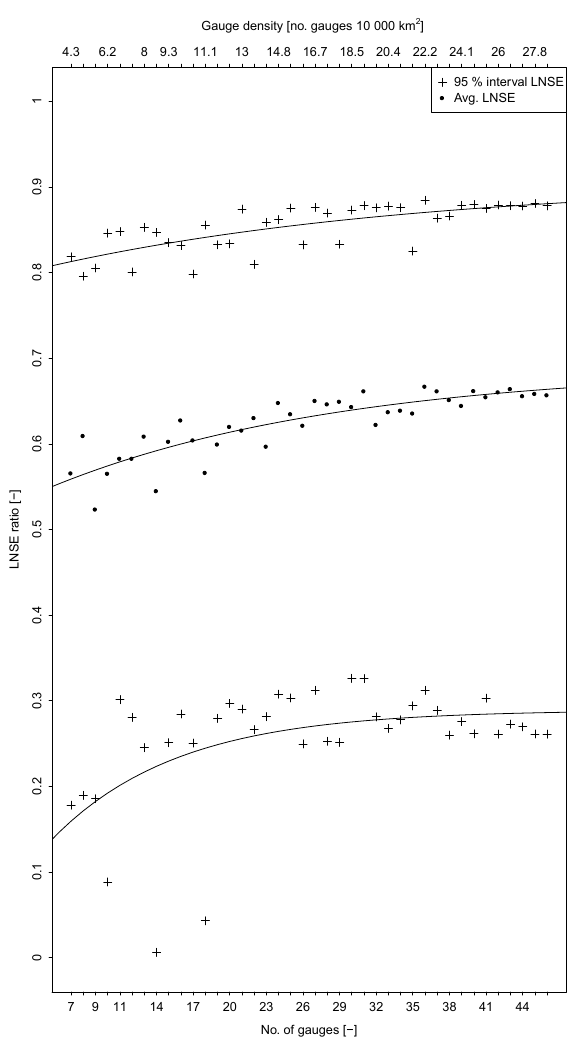
Figure 11. LNSE ratio (see Eq. 12) as a function of stream gauge availability: black dots represent the average of 11 LNSE ratio val- ues, while crosses indicate their 95% confidence